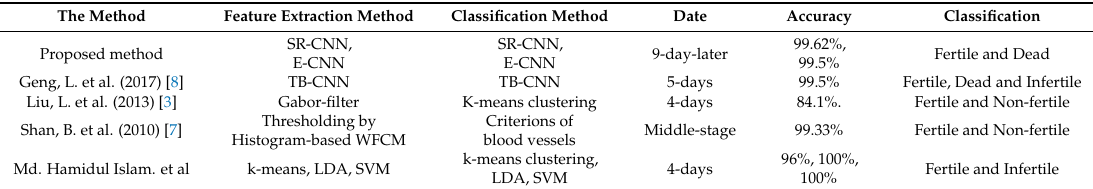
Table 8. Comparison of experimental